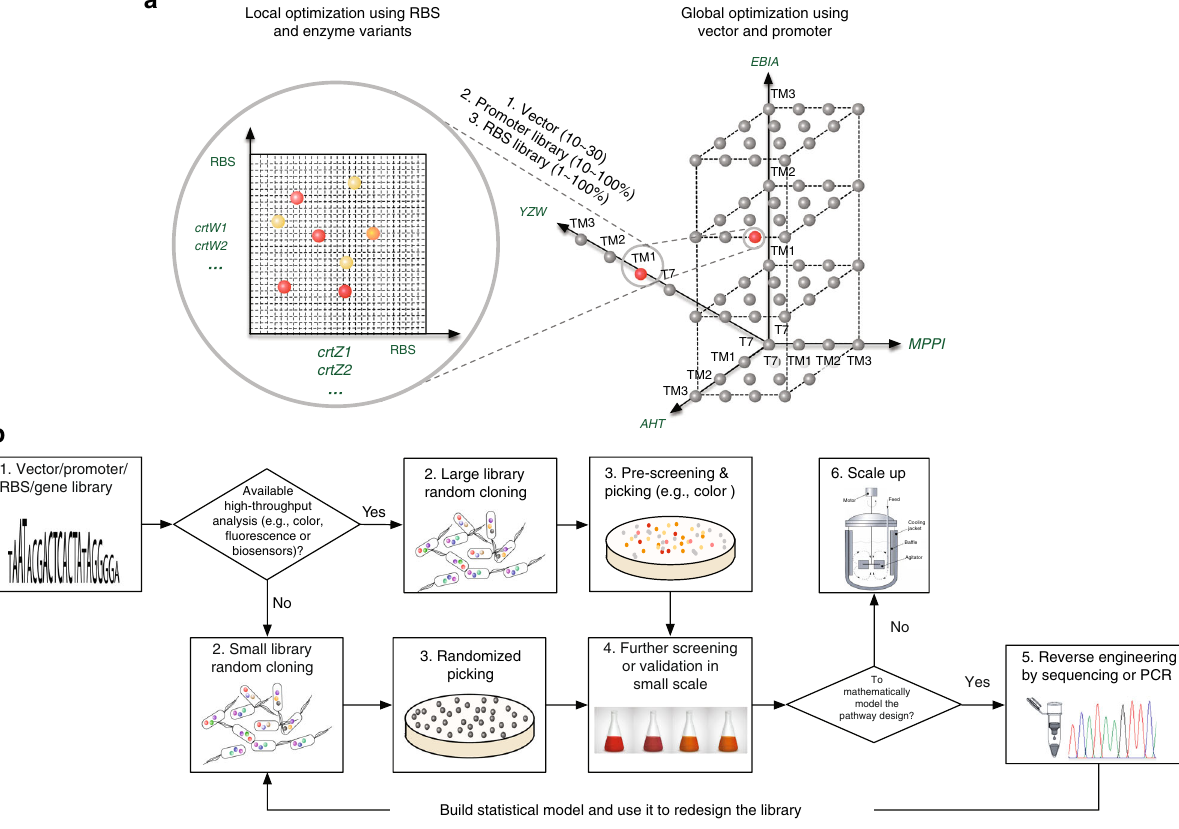
Fig. 4 Illustration of MHP and its work fl ow. a In MHP, pathway engineering proceeds either sequentially or simultaneously with global optimization (promoters) and local re fi nement (5 ′ UTRS or RBSs and enzyme variants). Globally, each promoter regulates the transcription of each operon/module with multiple genes (such as module AHT, MPPI, EBIA and YZW). Locally, various RBSs and enzymes facilitate fi ne tuning of the relative activities within one speci fi c module (such as crtW and crtZ gene in YZW module). b The MHP work fl ow. First, libraries of promoters and RBSs were established